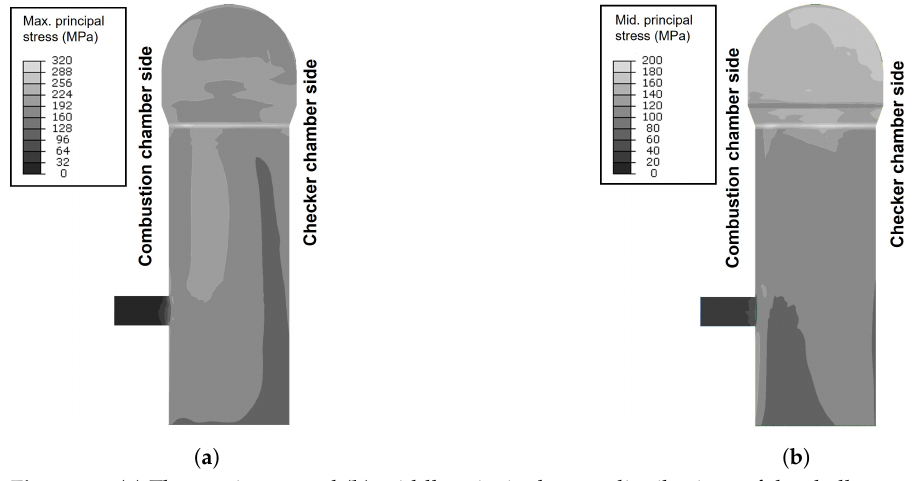
Figure 13. ( a ) The maximum and ( b ) middle principal stress distributions of the